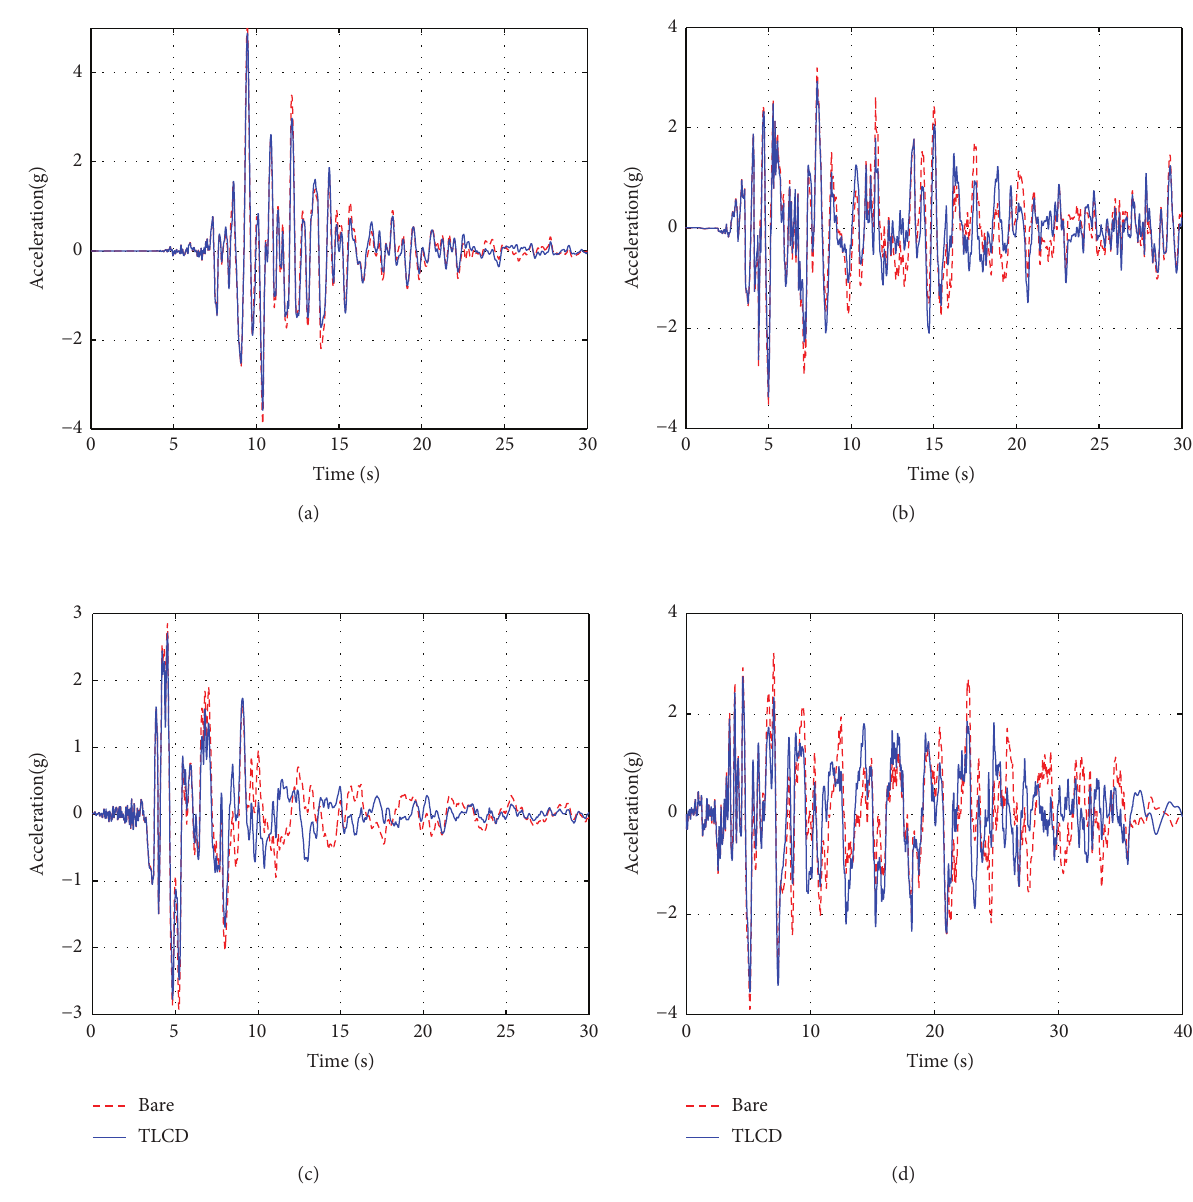
Figure 8: Time history comparison for the top floor acceleration: (a) under Kobe wave; (b) under El Centro wave; (c) under North wave; (d) under Hach